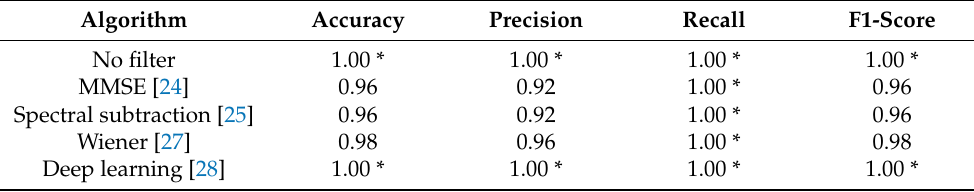
Table 10. White Noise SNR 10. * is the best result for each particular